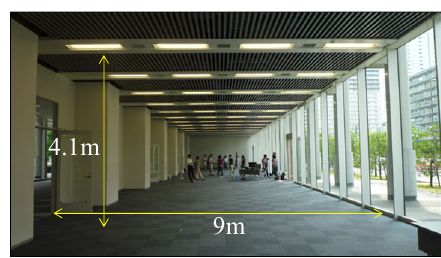
Figure 5. Study area